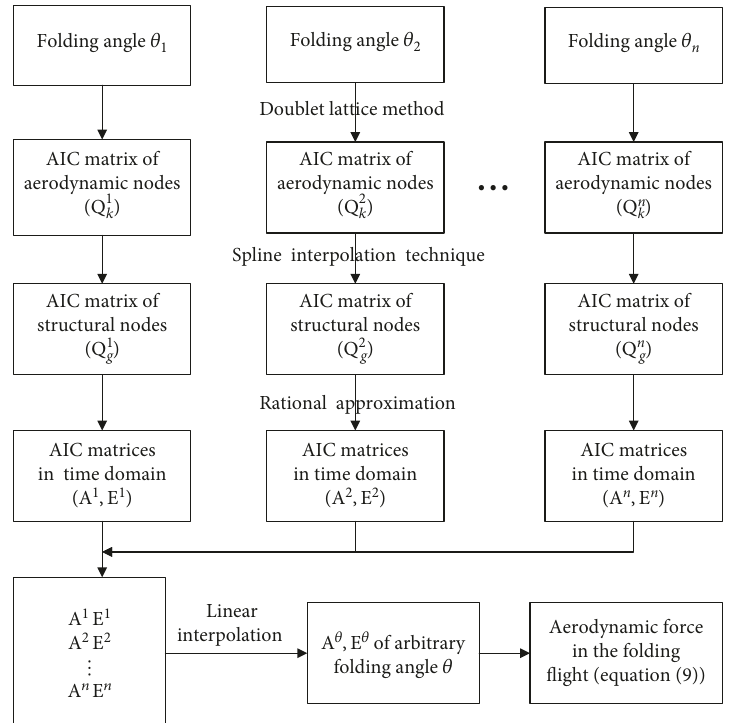
Figure 5: Flowchart of building the aerodynamic